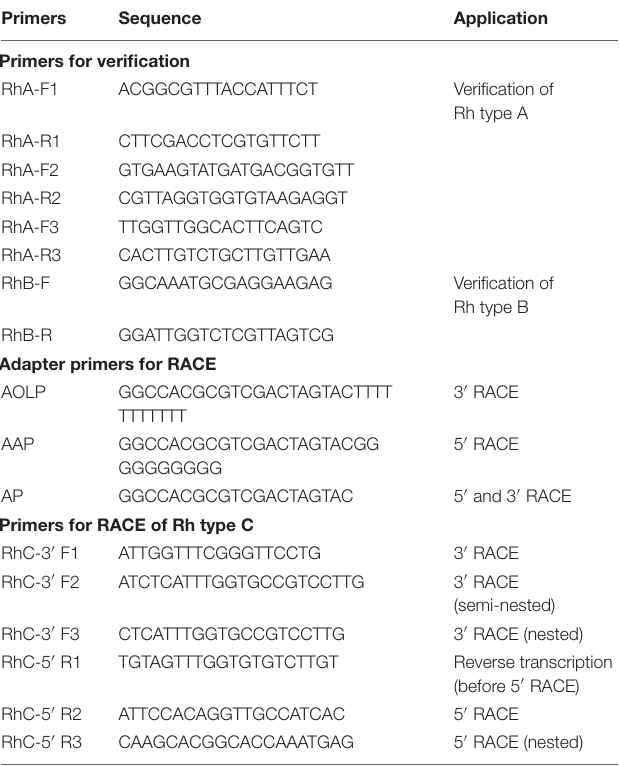
TABLE 1 | Primers (5 (cid:48) → 3 (cid:48) ) used for verification and rapid amplification of cDNA ends (RACE). Primers